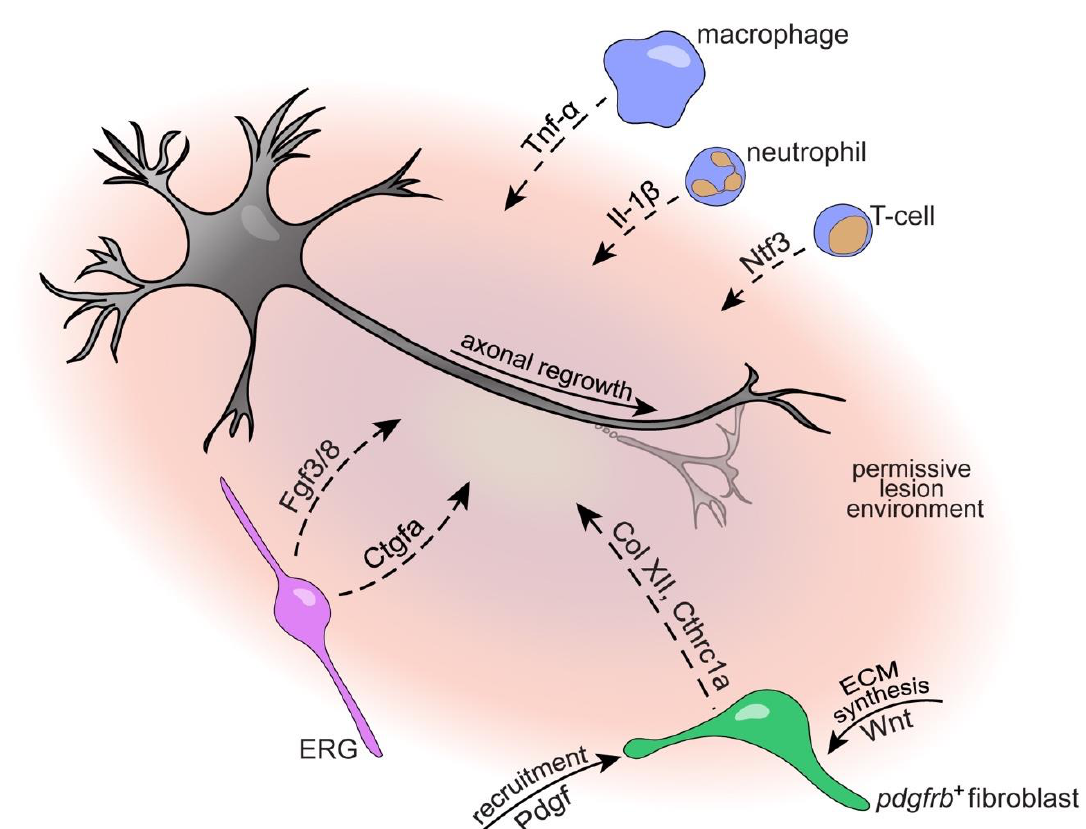
Figure 3. Key molecular and cellular players contributing to the axon growth-permissive lesion environment after SCI in zebrafish. ERGs secrete growth factors (Fgf, Ctgf), pdgfrb + fibroblasts deposit growth-conducive ECM (Col XII, Cthrc1a) molecules and immune cells dynamically control inflammation promoting axon regeneration. The roles of individual cells and contributing factors are described in detail in the main text. Arrows indicate direct interaction of secreted factors with target cells, dashed arrows indicate indirect interaction or not shown to be direct. Abbreviations: Tnf-a, tumor